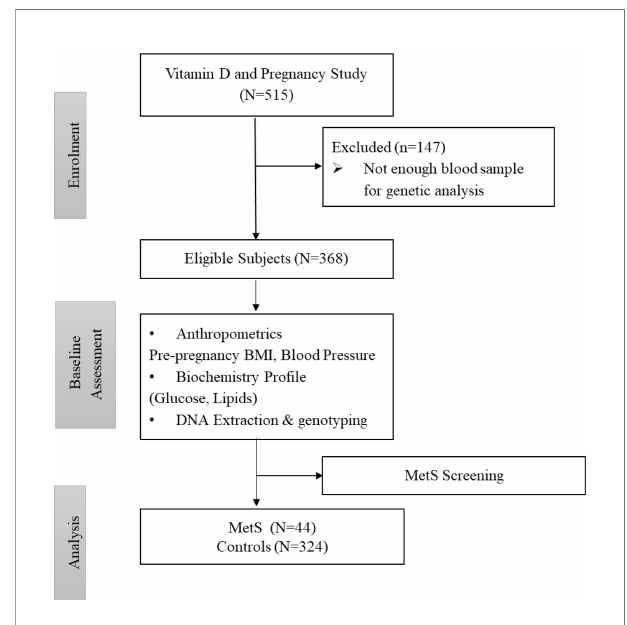
FIGURE 1 | Flowchart of